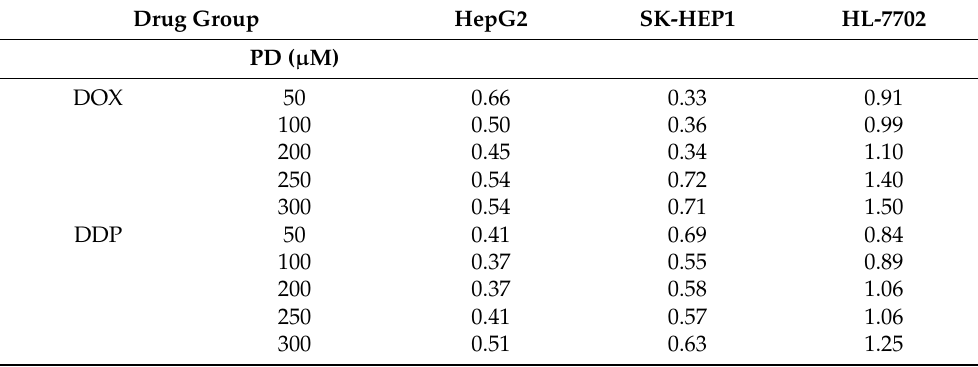
Table 2. The combination index (CI) values of the cotreatment of PD with DOX or DDP in HepG2, SK-HEP1 and HL-7702 cells. The CI values indicate the additive (CI = 1), antagonistic (CI > 1), or synergistic (CI < 1) effects of the